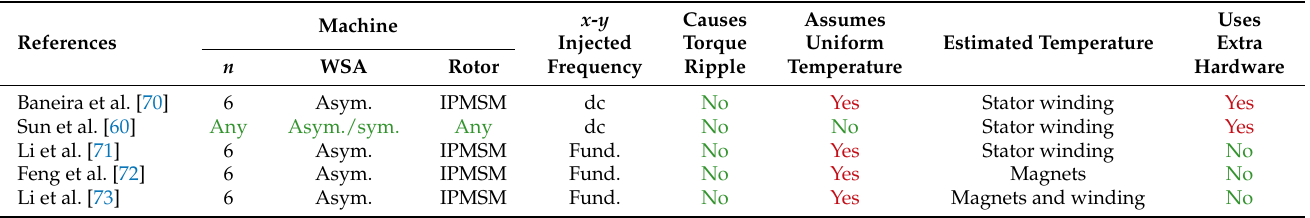
Table 22. Methods for detecting machine-cooling faults (Section 10.2) in multiphase applications in the